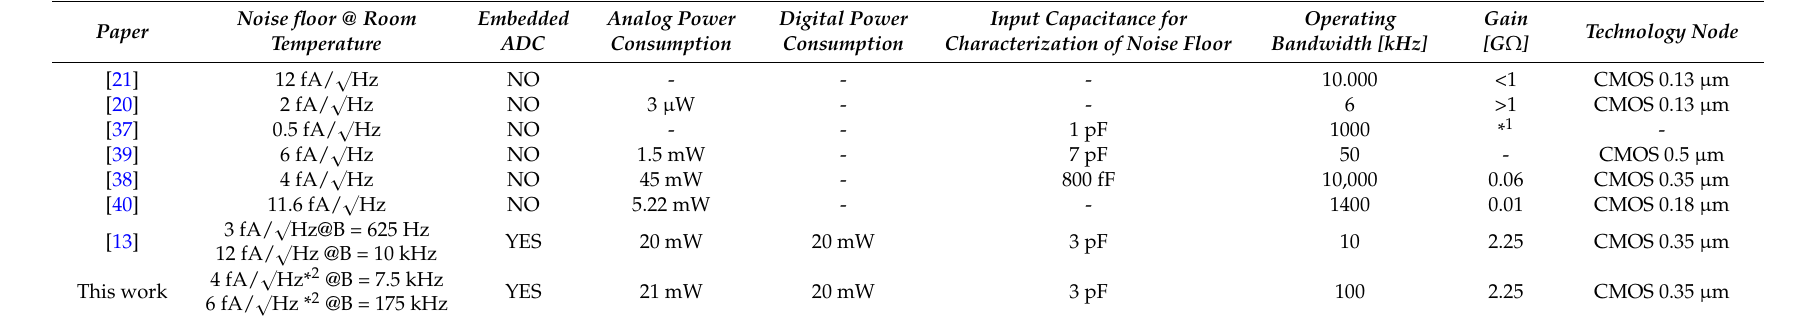
Table 3. State-of-the-art